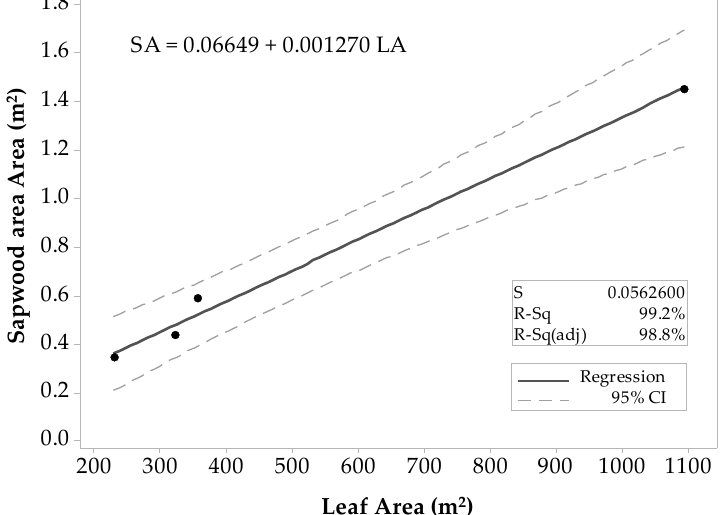
Figure 4. Fitted linear regression model for Populus tremuloides predicted SA plot in relation to its L A plot . This model does not include the stand Deciduous-6.